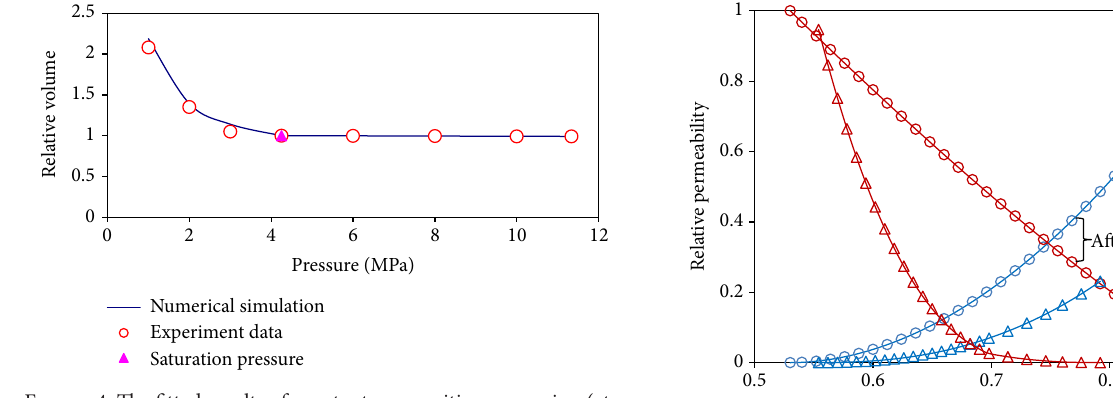
Figure 4: The fitted results of constant composition expansion (at a reservoir temperature of 59 ∘ C).